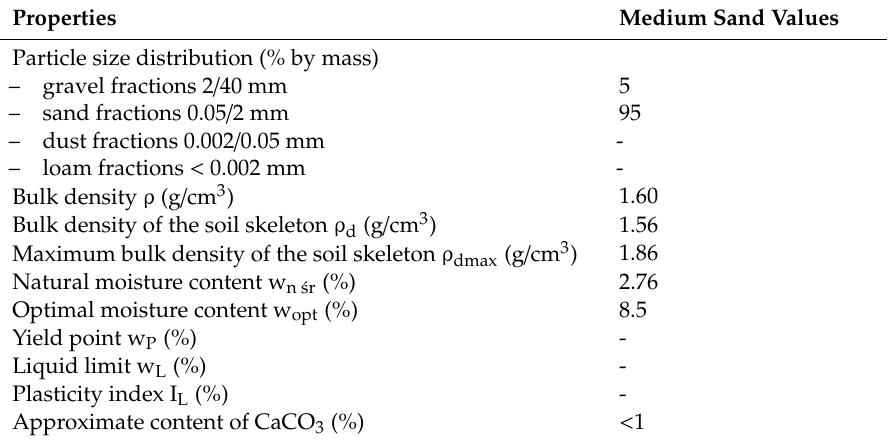
Table 2. Basic properties of non-cohesive soil selected for testing.